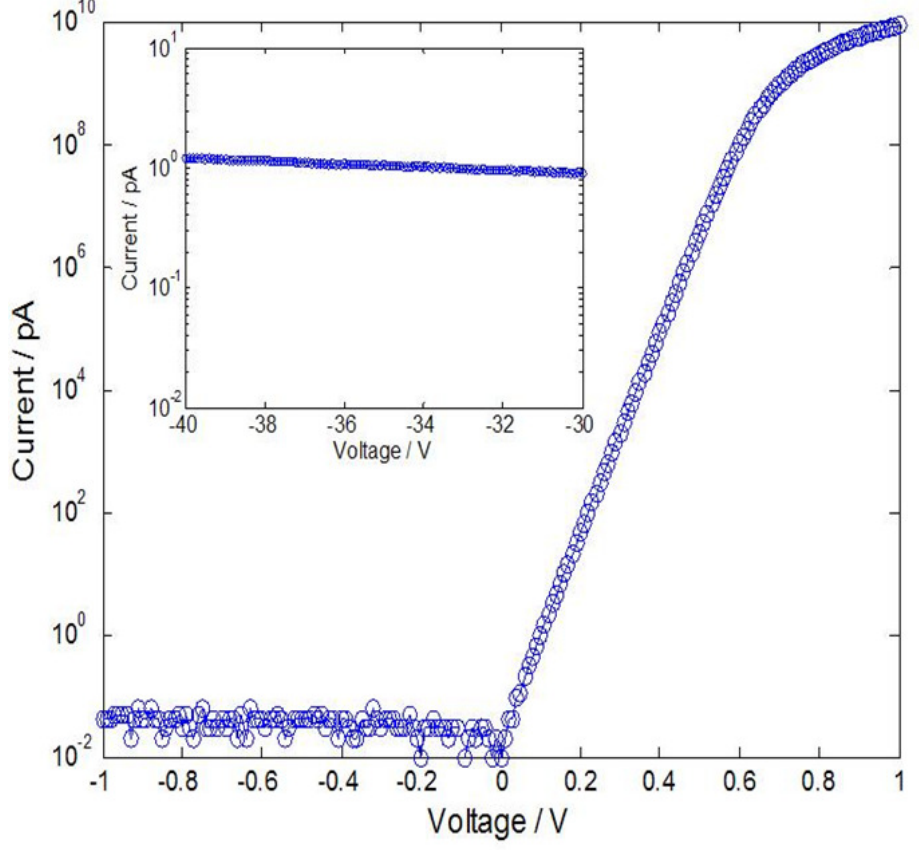
Figure 5. I-V characteristic of a boron-silicon diode with active area 300 × 300 µ m 2 . The inset shows a dark current of 1 pA with a reverse bias up to − 40V, corresponding to current density: ∼ 11 pA per square micrometer)